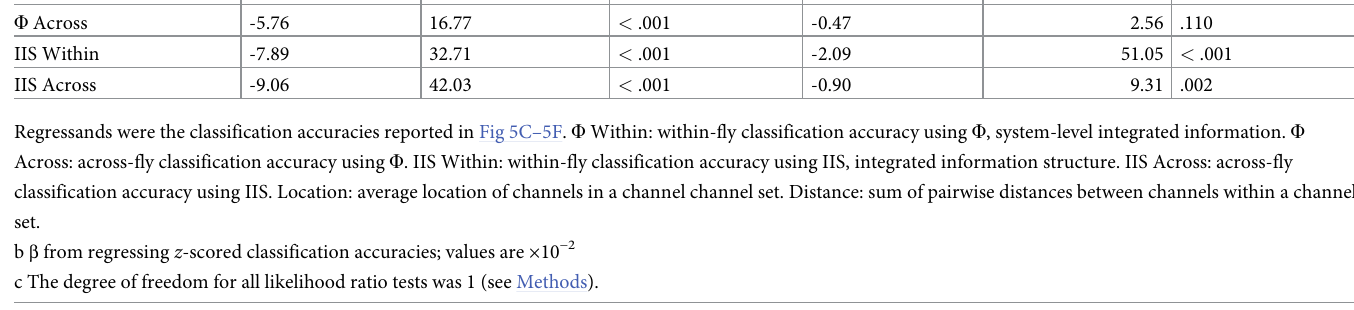
Table 1. Dependence of regressands on channel set location and distance among channels. Location Distance